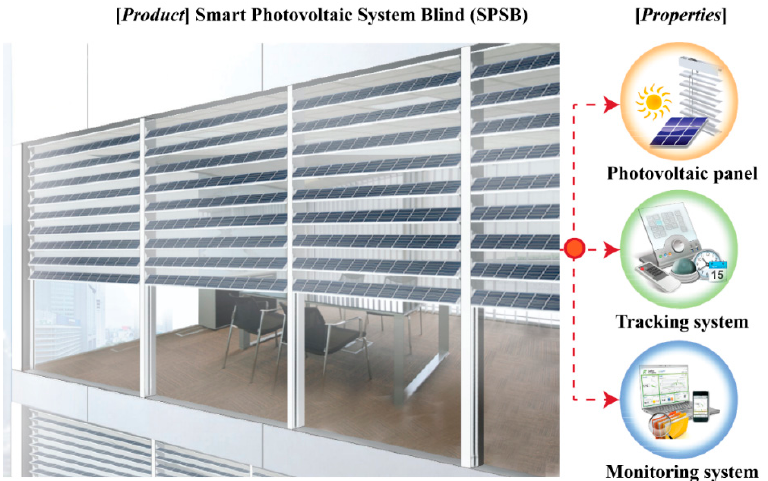
Figure 1. Concept of the smart photovoltaic system blind.